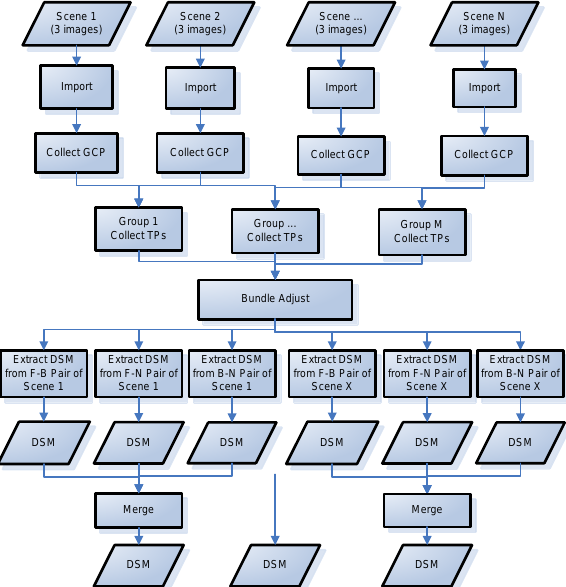
Figure 1. Design of DSM extraction workflow (in which F stands for forward, B for backward, and N for nadir) All DSMs merged from each scene may be mosaicked into a single DSM if